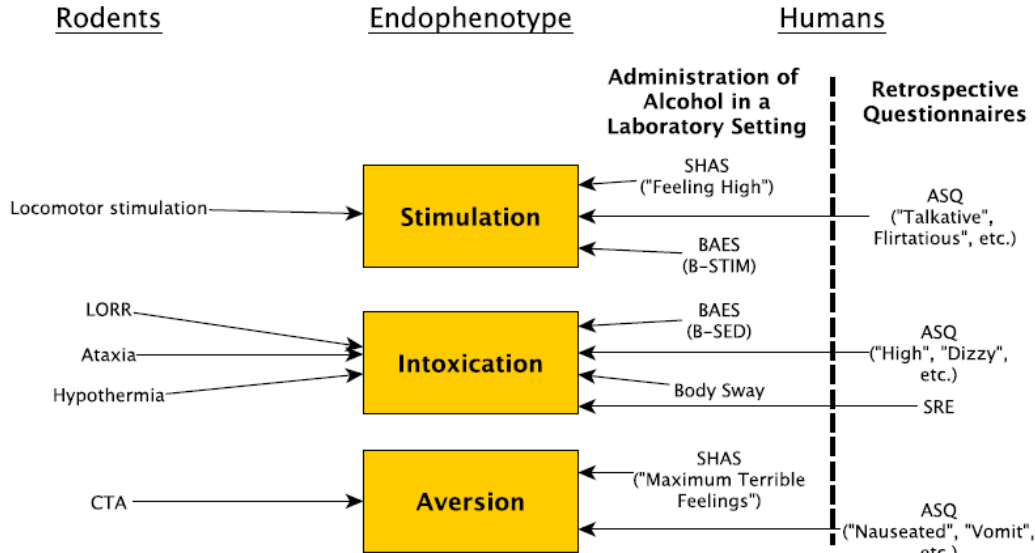
Figure 1. Tests used to evaluate the endophenotypes stimulation, intoxication, and aversion in humans and rodents. For humans, the Subjective High Assessment Scale (SHAS), Alcohol Sensitivity Questionnaire (ASQ), and Biphasic Alcohol E ff ects Scale (BAES) evaluate more than one endophenotype. In addition, body sway is used to measure intoxication in humans. For rodents, locomotor stimulation and conditioned taste aversion (CTA) assess stimulation and aversion, respectively, and multiple tests are used to measure intoxication including loss of righting response (LORR), ataxia, and hypothermia.